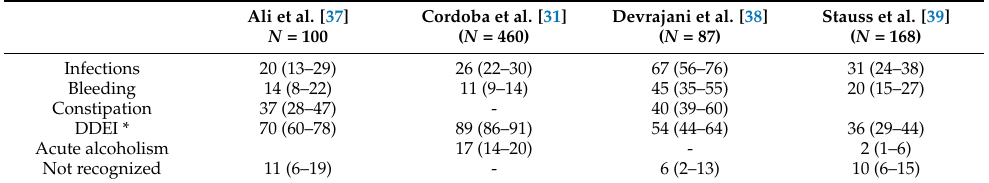
Table 1. Prevalence (percentage and 95% CI) of precipitating factors for hepatic encephalopathy (HE).